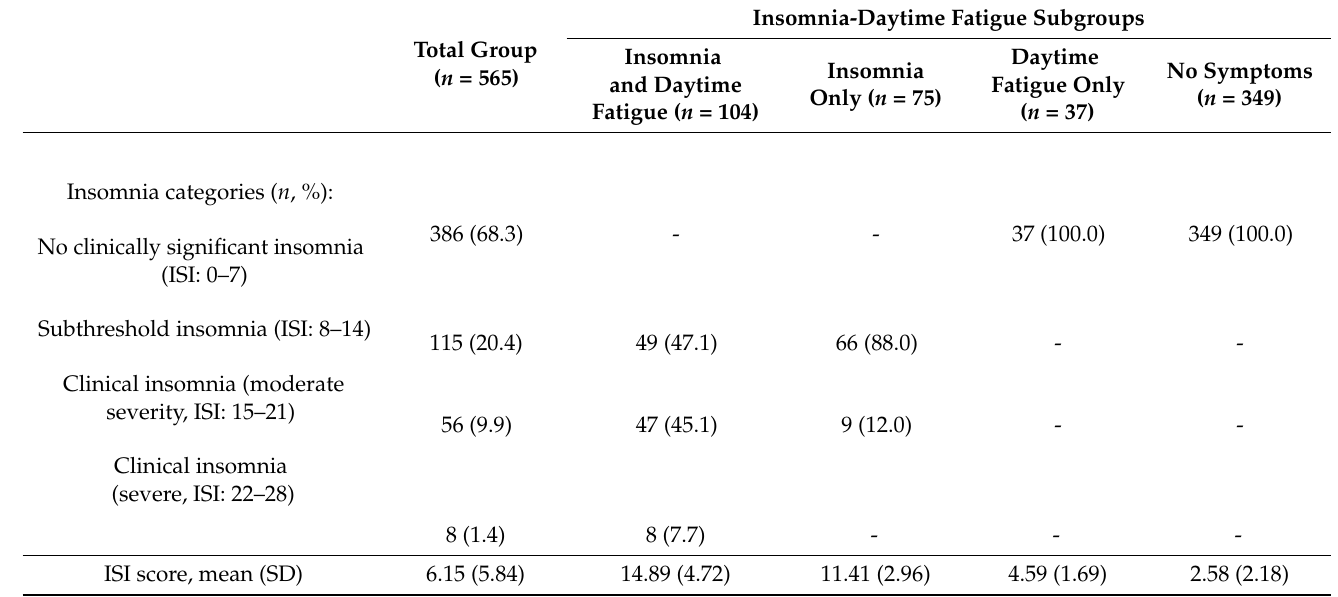
Table 2. Insomnia clinical severity categories and ISI scores per total and subgroup. Insomnia-Daytime Fatigue Subgroups Total Group Insomnia ( n = 565) and